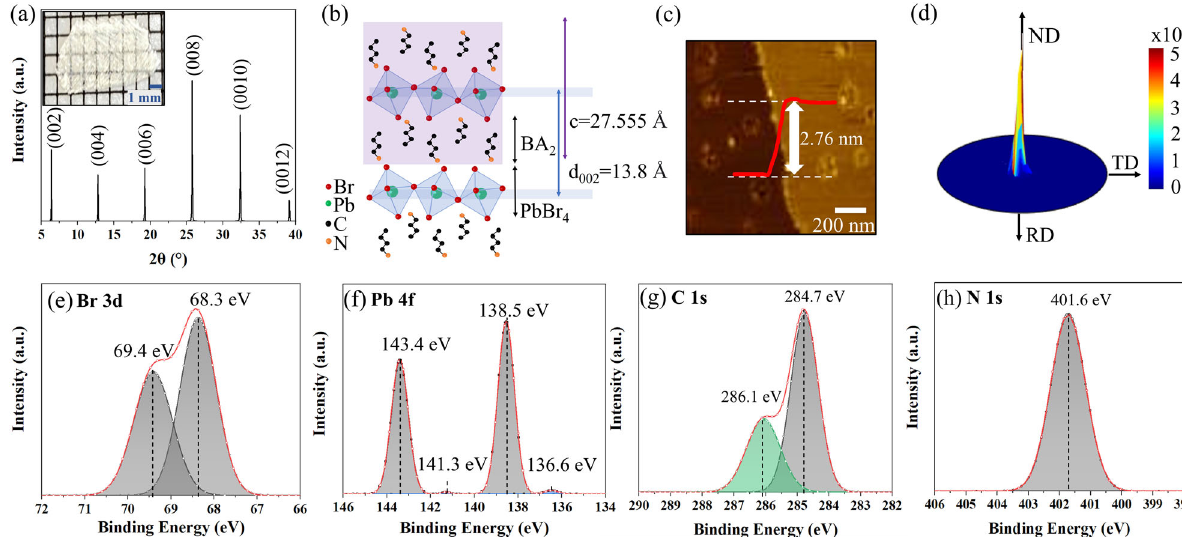
Fig. 1 Con fi rmation of synthesised BA 2 PbBr 4 crystallinity and surface properties. a XRD pattern of exfoliated BA 2 PbBr 4 . The insert is an optical image of the BA 2 PbBr 4 single crystal. b Schematic of the crystal structure (Ruddlesden – Popper) of BA 2 PbBr 4 based on XRD patterns. c AFM topography image of an exfoliated BA 2 PbBr 4 single crystal. d Pole fi gure for (008) plane. ND ( θ ), RD ( Φ ), TD ( Ψ ) represent normal direction, rolling direction, and transverse direction, respectively. The (008) direction (2 θ = 25.7 °) was the surface-normal direction. XPS spectra of the exfoliated BA 2 PbBr 4 sample for e Br 3 d , f Pb 4 f , g C 1 s , and h N 1 s ,